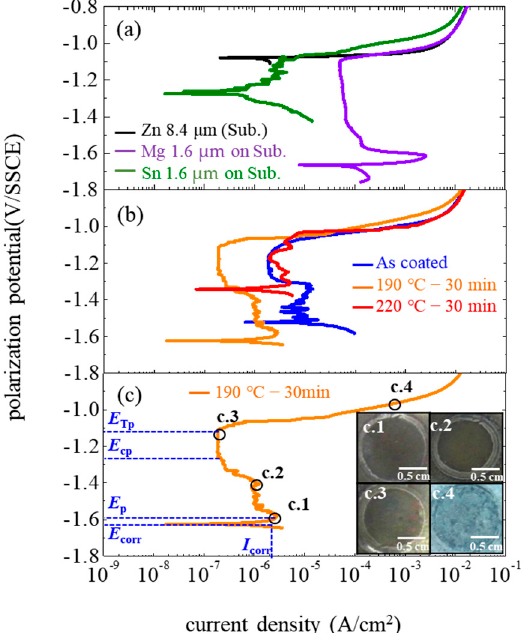
Figure 7. Polarization curves of Sn/Mg films and competitive films. ( a ) competitive films; HDG substrate; Mg and Sn single film on HDG. ( b ) Sn/Mg films depending on heating conditions. ( c ) digital images at four different points of the polarization test with Sn/Mg films prepared at 190 °C. I corr − corrosion current density; E corr − corrosion potential; E p − passivation potential; E cp − passivation complete potential; E Tp − transpassive potential.